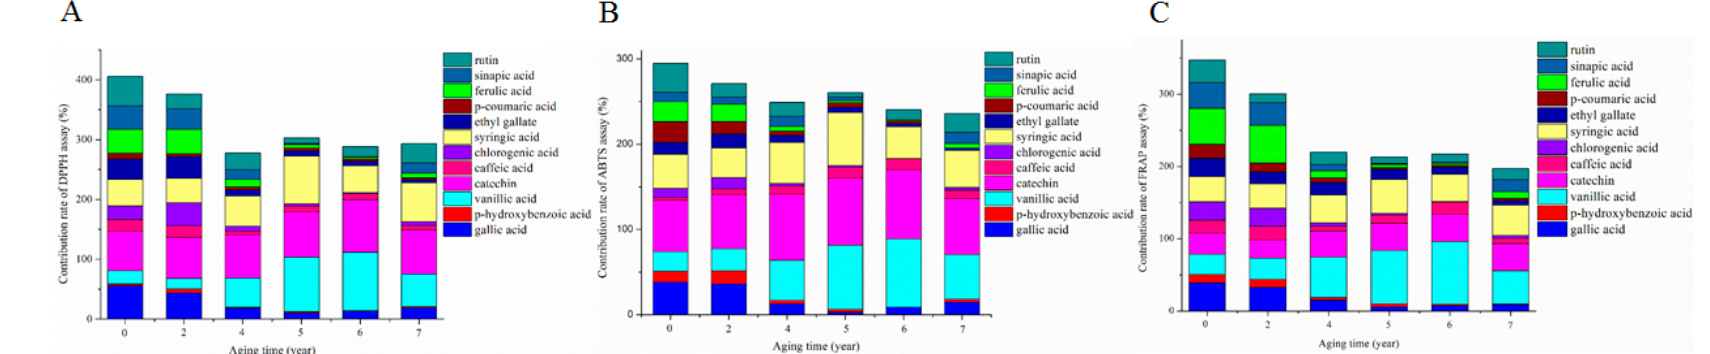
Figure 5. Antioxidant contribution of main phenolic compounds during the aging process of ZAV. Antioxidant activities of phenolic compounds mixture were detected by DPPH assay ( A ), ABTS assay ( B ), and FRAP assay ( C ) during the AP of ZAV.